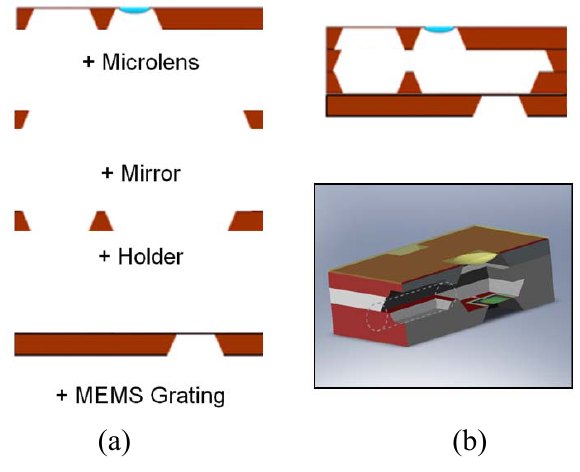
Figure 3. (a) Multi-layer silicon cavity packaging of microlens and other MEMS components of the micro-spectrometer. (b) The 5 mm by 5 mm package with cross-section (top) and perspective (bottom)